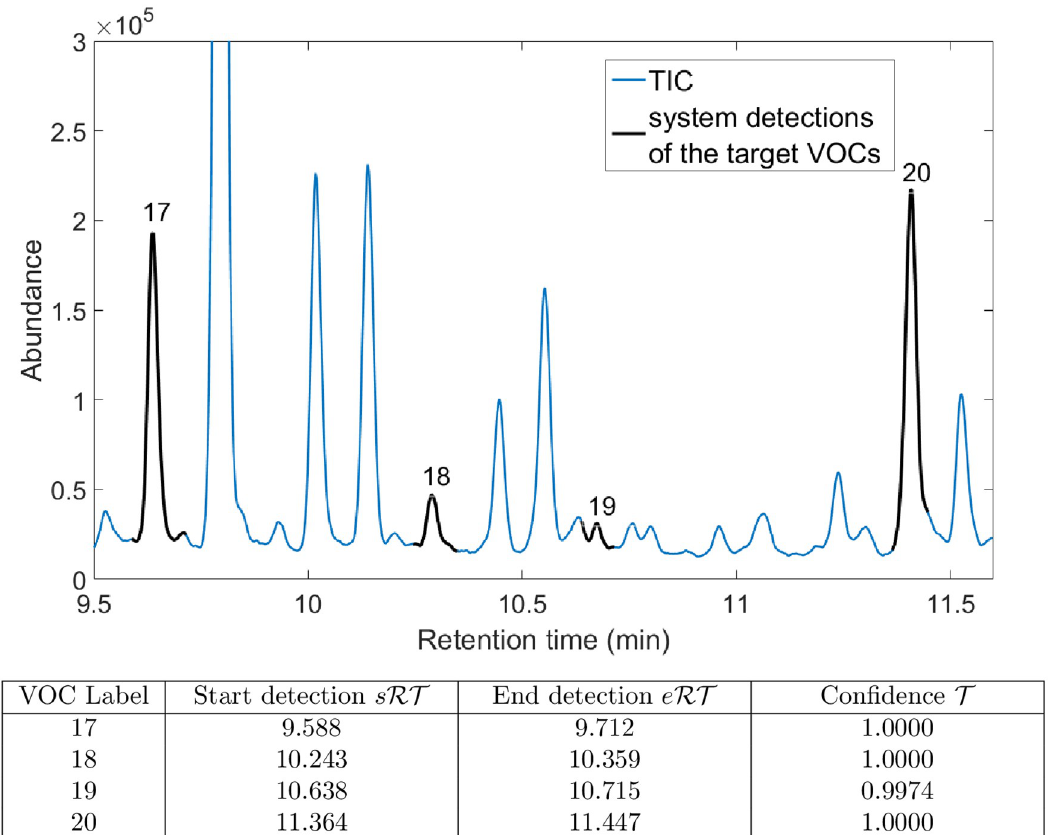
Fig 5. Example output from clinical sample scanning for VOC detection (stage 2) with a CNN-based system, range between 9.5 and 11.5 minutes; sample Test-01-BS01, model VGG-8–1D (S4.2.1 Table in S1 File). Top: VOCs detected by the system in this RT range, visualised on the TIC chromatogram. Bottom: Table of detected VOCs along with their RT positions and detection confidences.